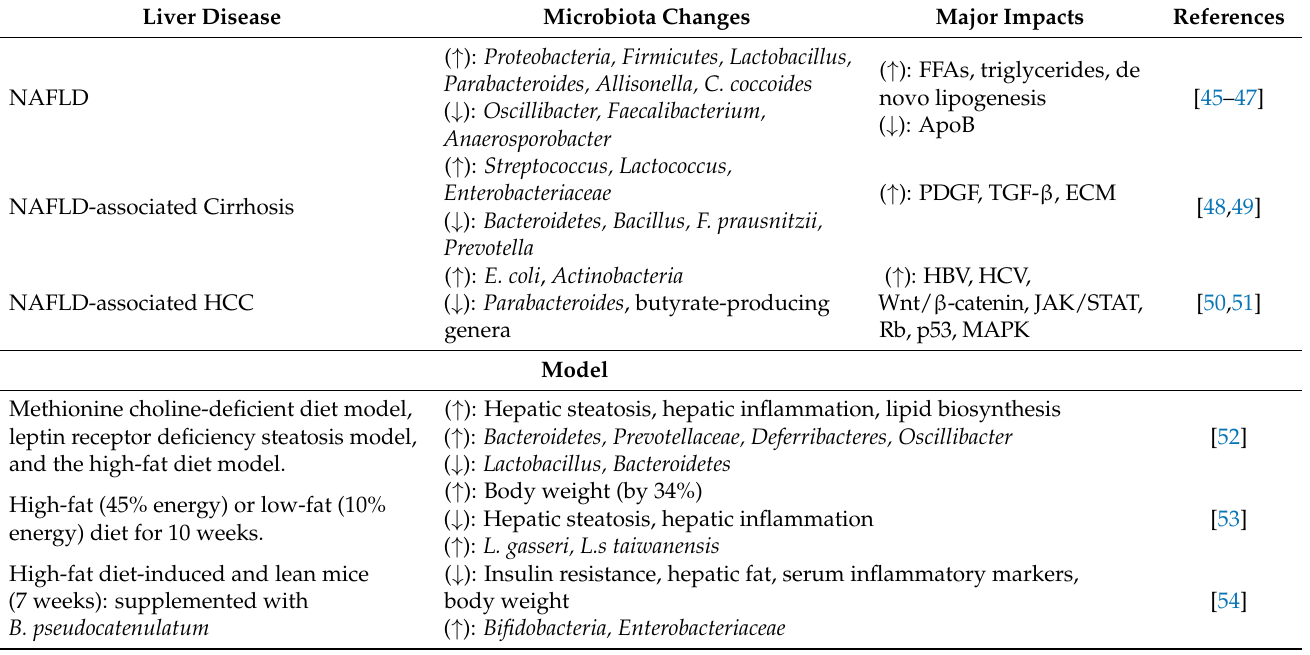
Table 2. The alterations in gut microbiota in the pathogenesis of nonalcoholic fatty liver disease. Liver